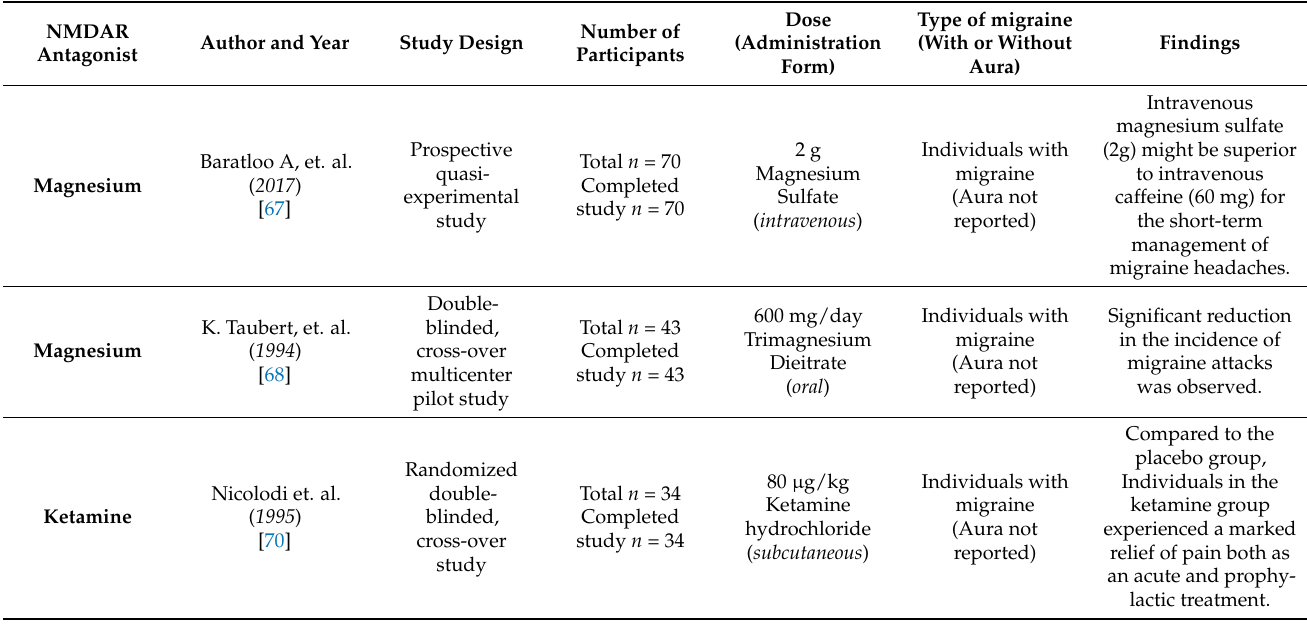
Table 2. Clinical studies investigating NMDAR